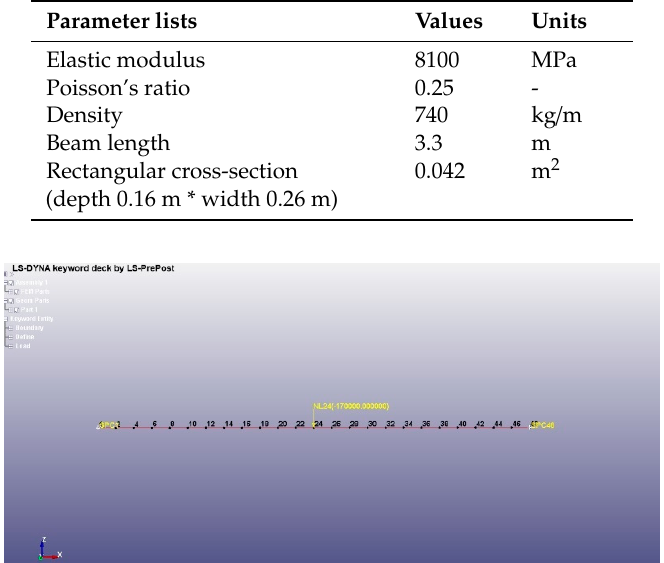
Figure 13. Finite element simulation model of a simply supported FFU composite beam.